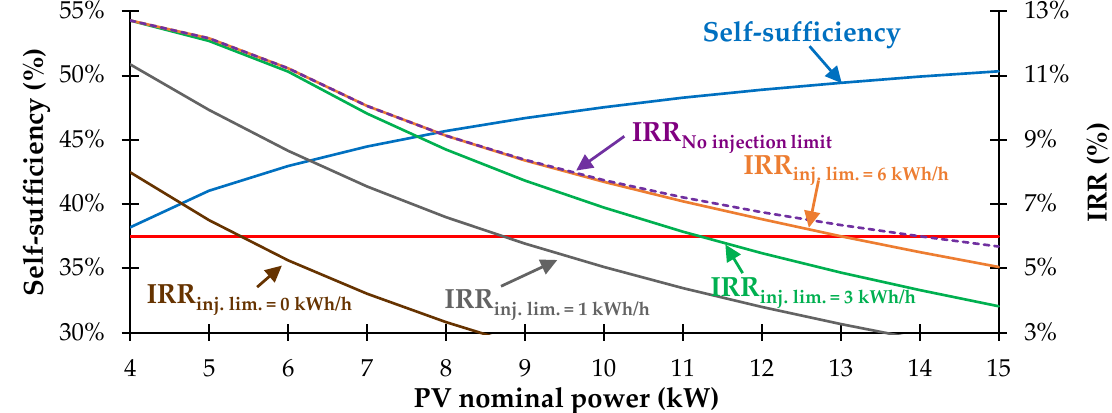
Figure 9. Self-sufficiency and IRR as functions of PV nominal power for different injection limits.